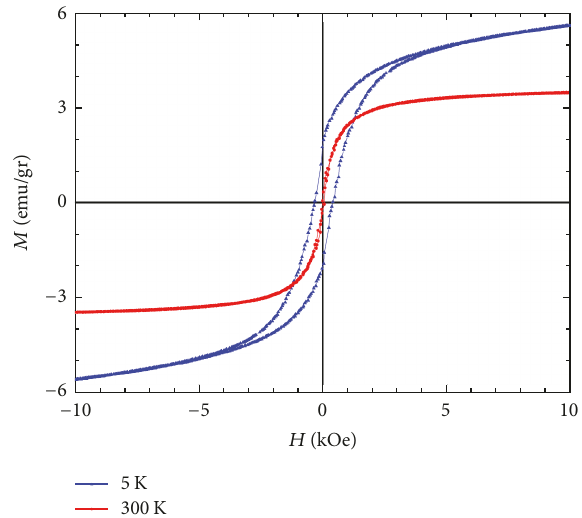
Figure 9: Hysteresis loops obtained at 5 K and 300 K for CoNPs